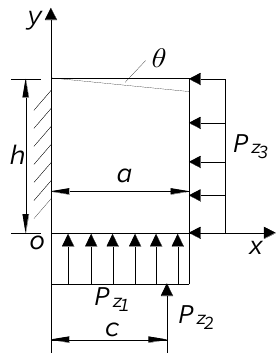
Figure 19. Simplified mechanical model of the entry direct roof .